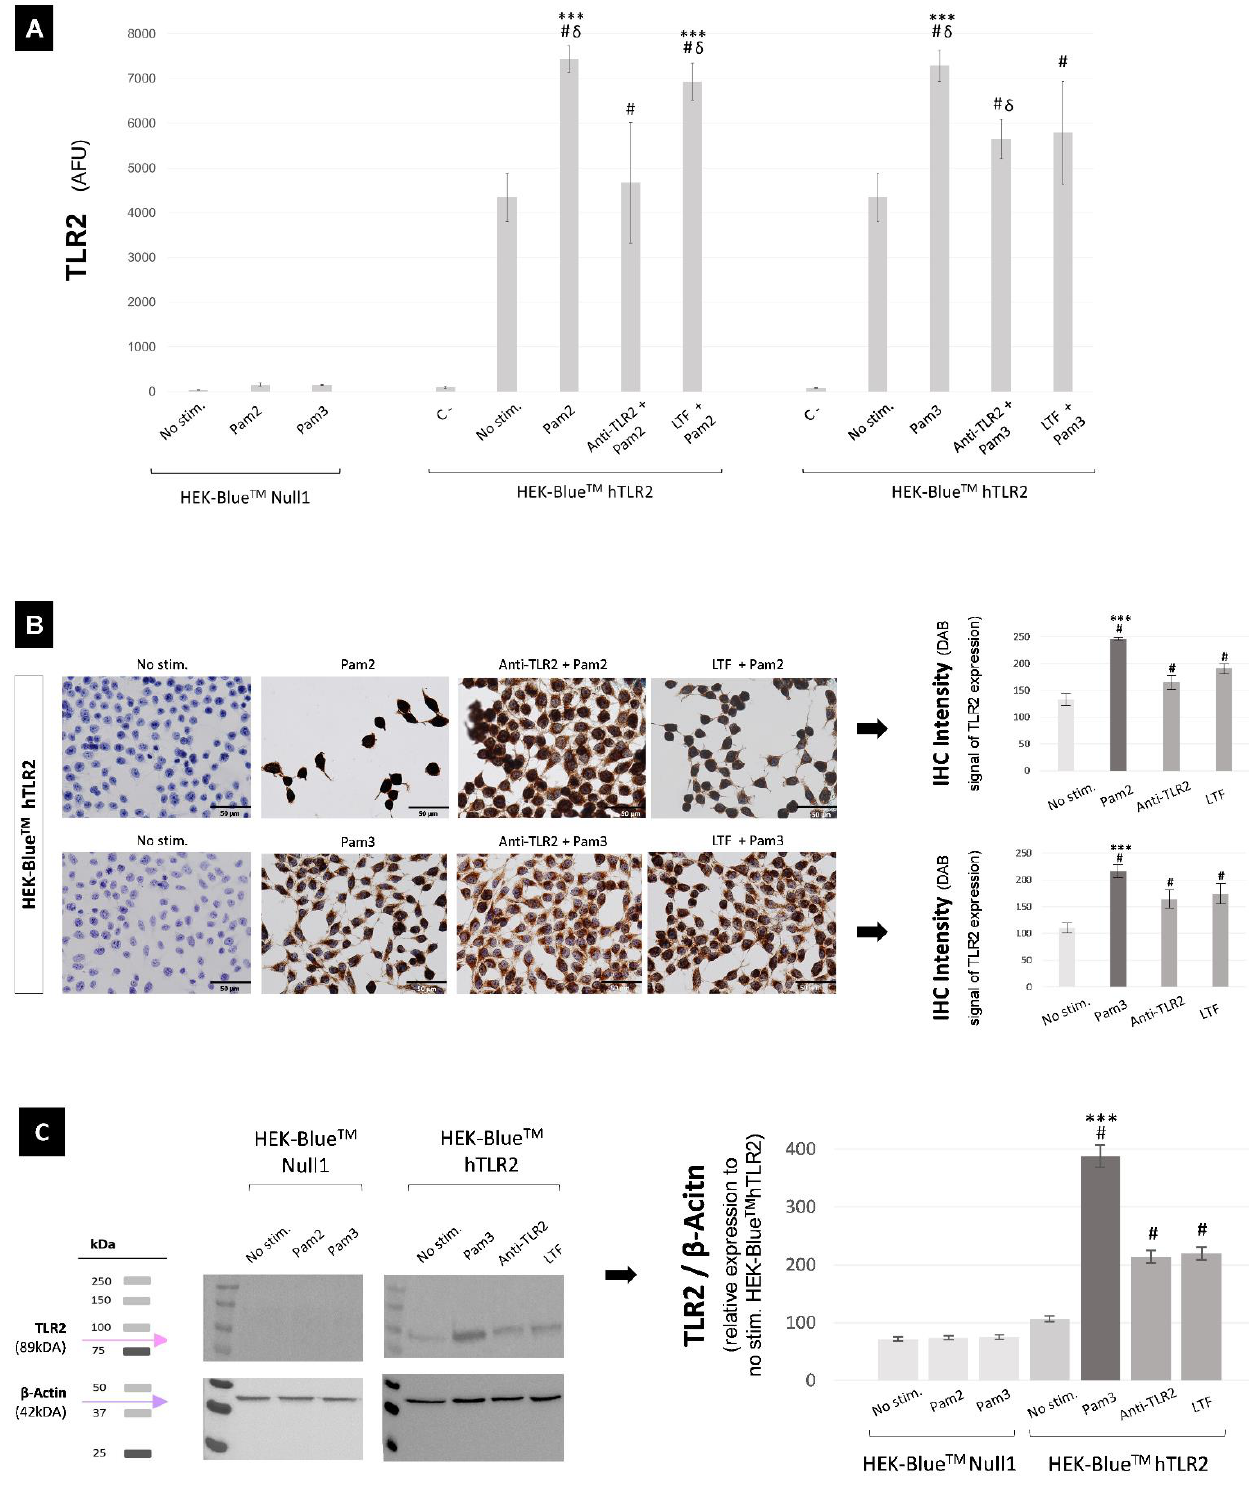
Figure 4. TLR2 protein expression in unstimulated, stimulated, neutralized, and immunomodulated HEK-Blue TM cell cultures, measured by flow cytometry ( A ), immunohistochemistry ( B ), and WB ( C ). ( A ) Statistical differences with regard to: # p < 0.0001 HEK-Blue TM Null1 and unlabeled cells (negative control), δ p < 0.001 unstimulated cells, *** p < 0.05 all groups. ( B ) Microscopic images of HEK- Blue TM hTLR2 cells at a 40× magnification, and quantification of the intensity of staining; statistical differences with regard to: # p < 0.0001 unstimulated HEK-Blue TM hTLR2, *** p < 0.0001 LTF and Anti-